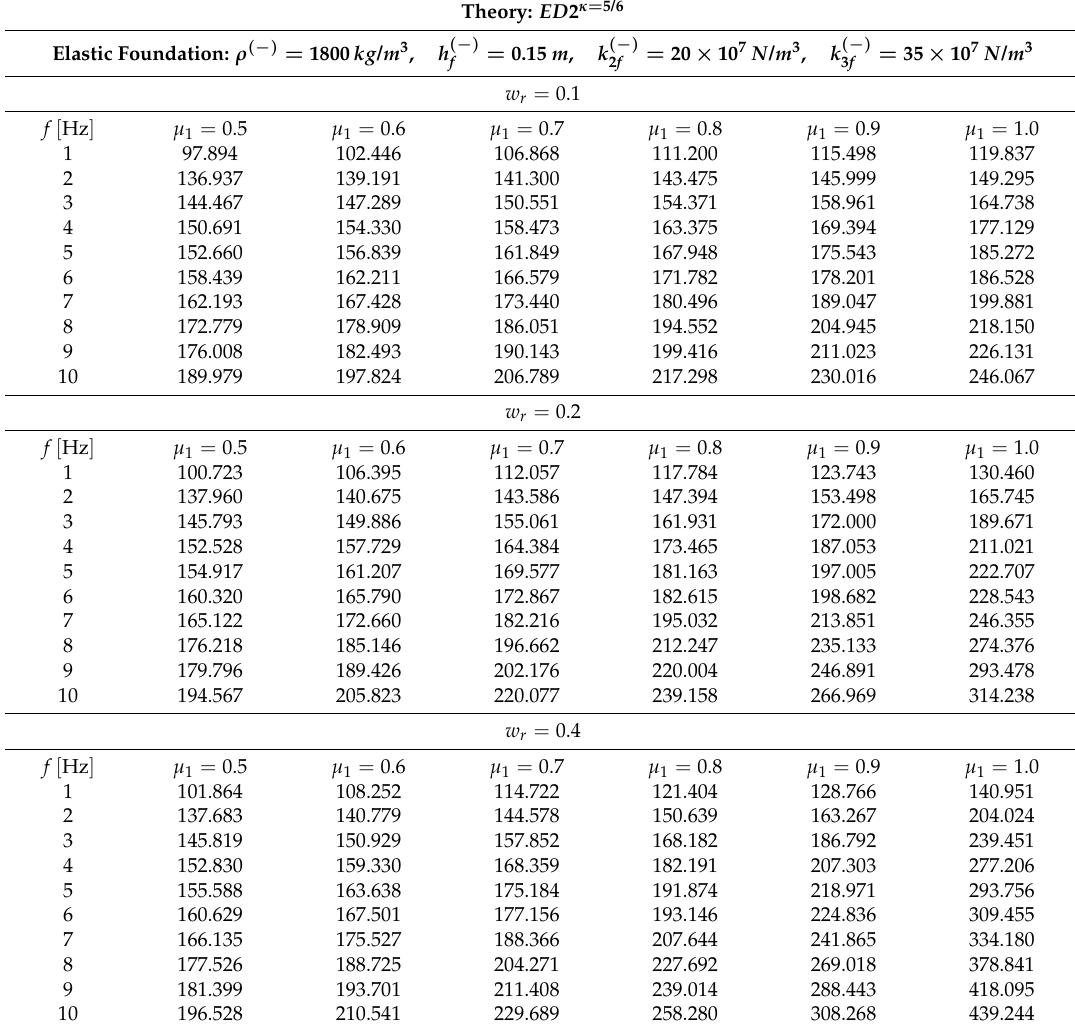
Table 11. First ten natural frequency variations for ED2 κ = 5/6 theory of a CCFF helicoidal surface (Figure 4c) reinforced by CNTs distributed as in Figure 5c for different mass fractions w r when varying the parameter of agglomeration µ 1 with µ 2 = 1. The Chebyshev-Gauss-Lobatto grid distribution was employed, with I N = 31, I M =